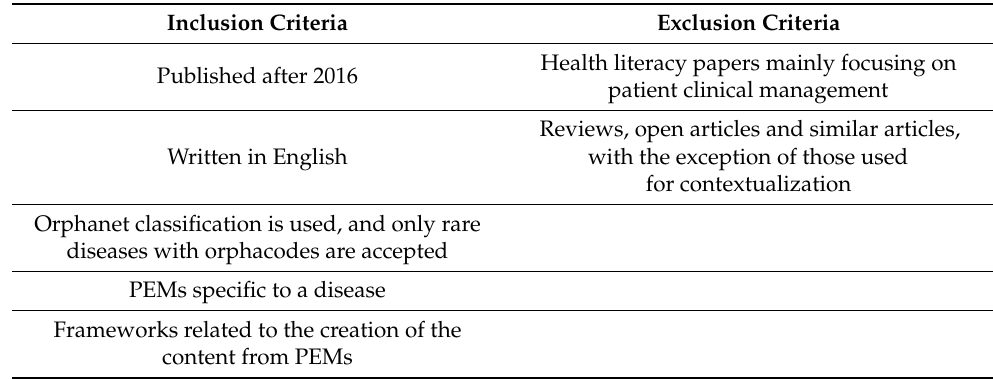
Table 1. Selection criteria used for the inclusion of articles of interest for this